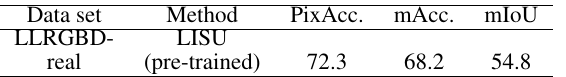
Figure 5. Qualitative results on LLRGBD-real. (a) is the input low-light images, and (b) shows the corresponding normal-light Table 5. Evaluation of the effectiveness of pre-training on images; (c): DLv3p (Chen et al., 2018b); (d): LISU-seg; (e) LLRGBD-synthetic. LISU; (f) LISU (pre-trained on LLRGBD-synthetic); (g)